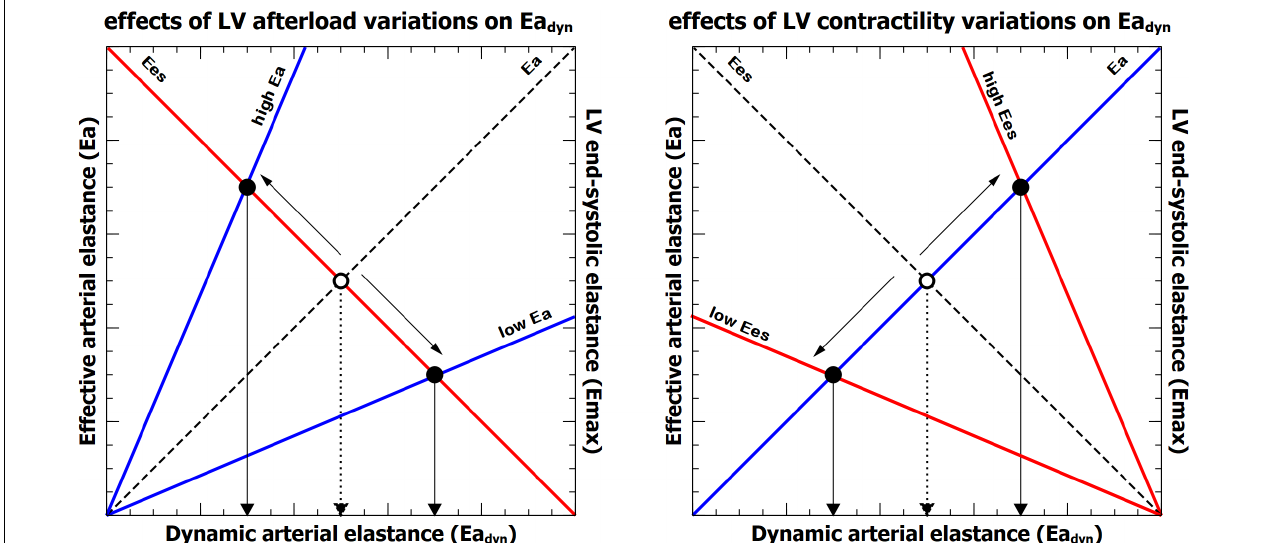
FIGURE 6 | Representation of the relationship between effective arterial elastance (Ea, blue line), left ventricular end-systolic elastance (Ees, red line) and dynamic arterial elastance (Ea dyn ). Left: effects of isolated variations on left ventricular afterload (Ea) on Ea dyn . Right, effects of isolated changes of left ventricular contractility (Ees). The dashed line and open circle represent the baseline condition. The intersection between Ea and Ees defines the value of Ea dyn on the x-axis for each ventriculo-arterial coupling (Ea/Ees)